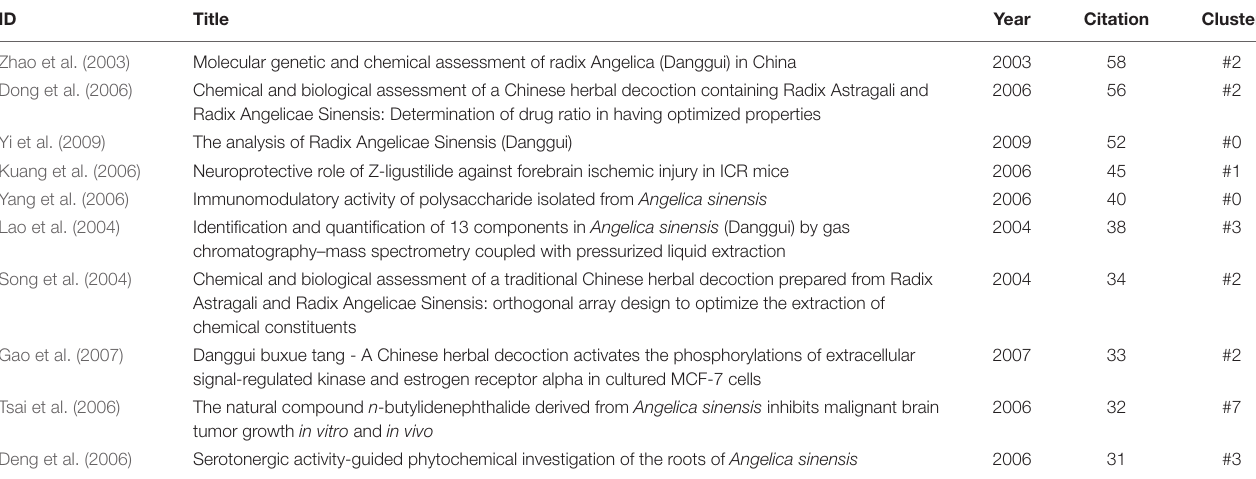
TABLE 3 | The most highly cited publications in the local dataset.